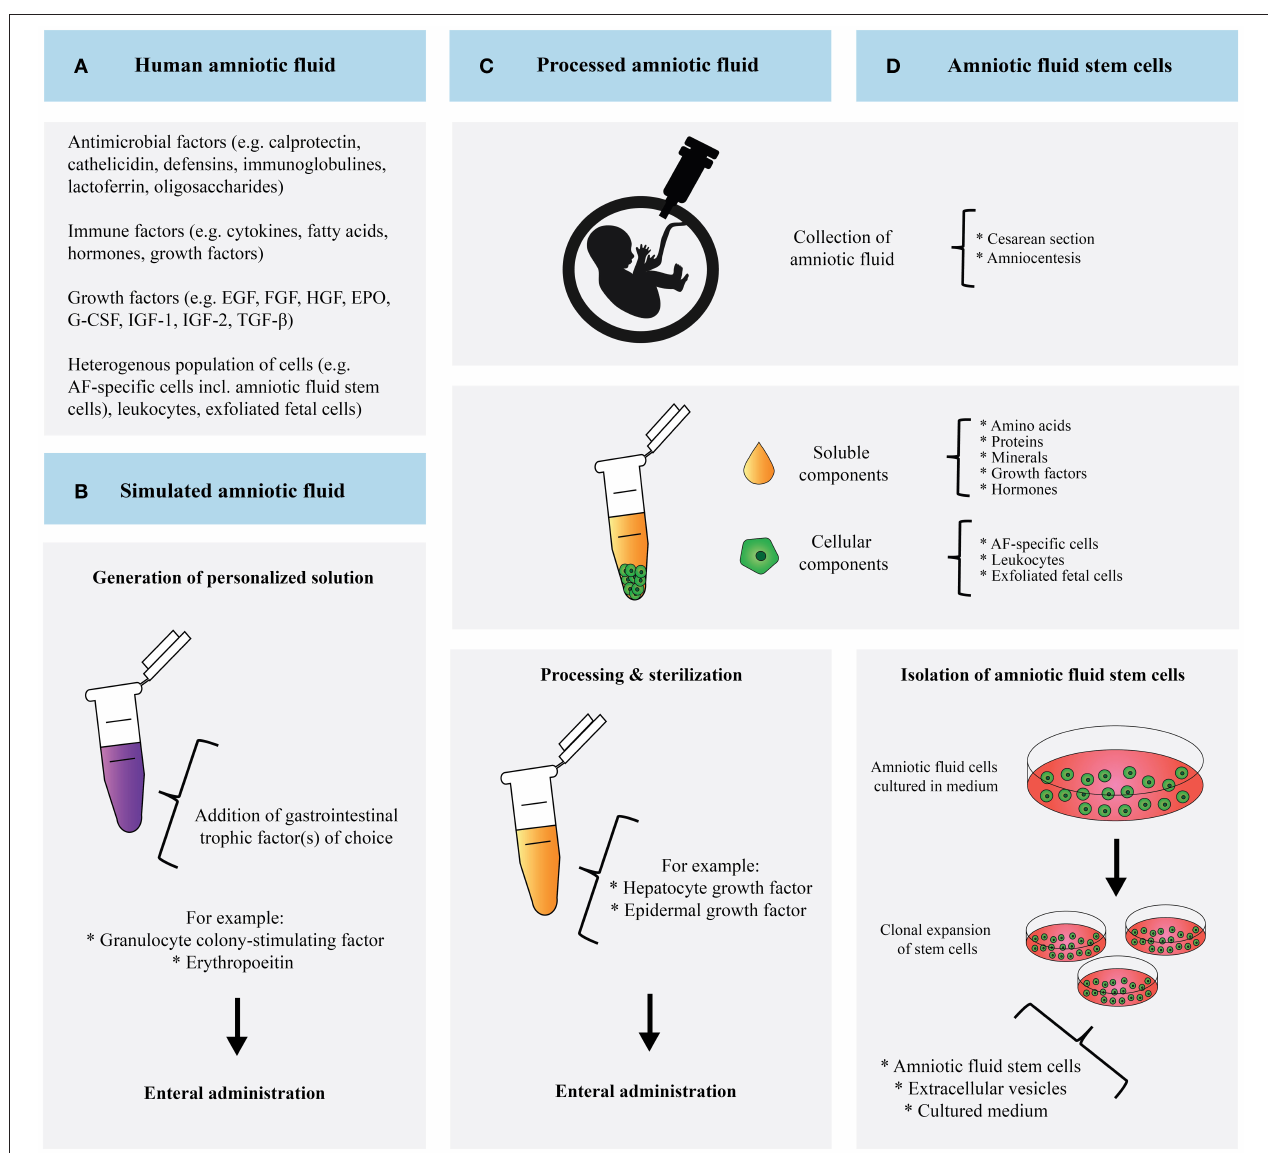
FIGURE 2 | Schematic overview and comparison of human amniotic fluid (A) , simulated amniotic fluid (B) , processed amniotic fluid (C) , and amniotic fluid derived stem cells (D) .